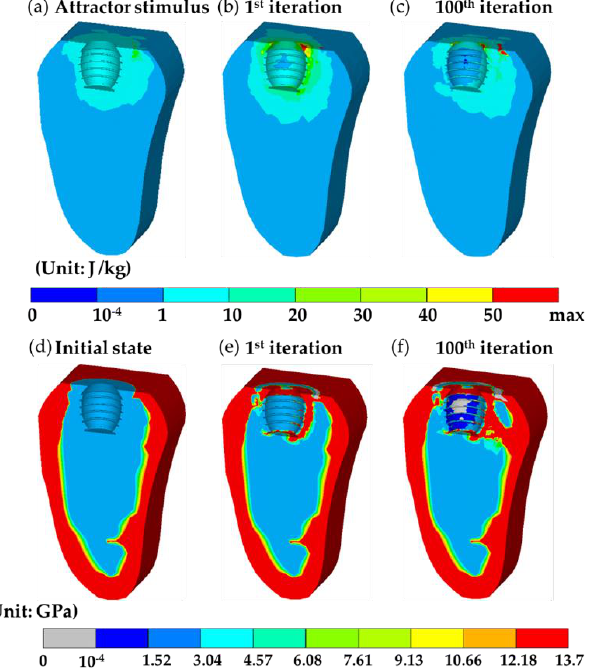
Figure 6. The results generated by the conventional model. ( a ) The target distribution of the attractor (cid:42) stimulus 𝐾(𝑟⃑ ) based on the natural tooth. ( b , c ) are bone remodeling stimulus ( 𝑆 𝐵𝑅 ) at the 1st and 100th iterations. ( d – f ) are the corresponding distribution of Young’s modulus during the bone remodeling process at the initial state, 1st, and 100th iteration.